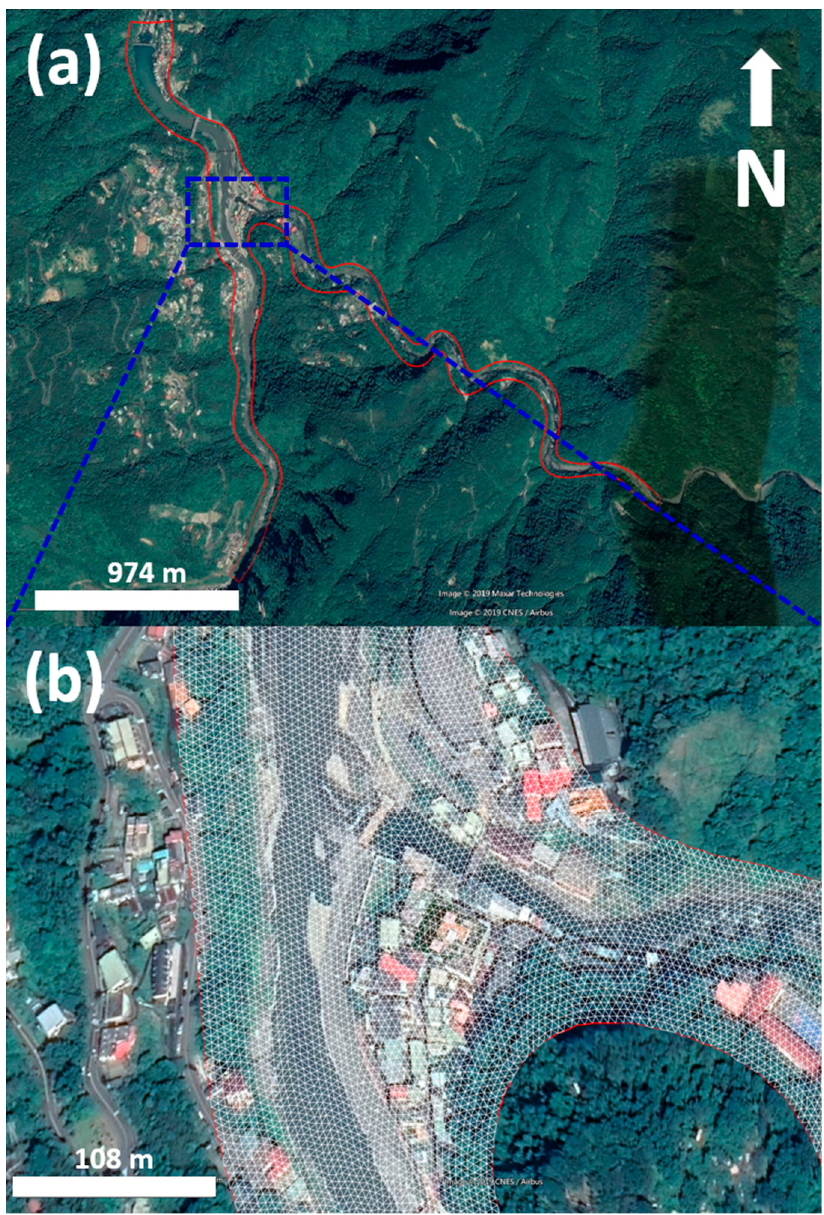
Figure 5. The computational domain of the hydrodynamic model ( a ) and an enlargement of the Wulai Street area with the high-resolution unstructured grids of the hydrodynamic model ( b ).